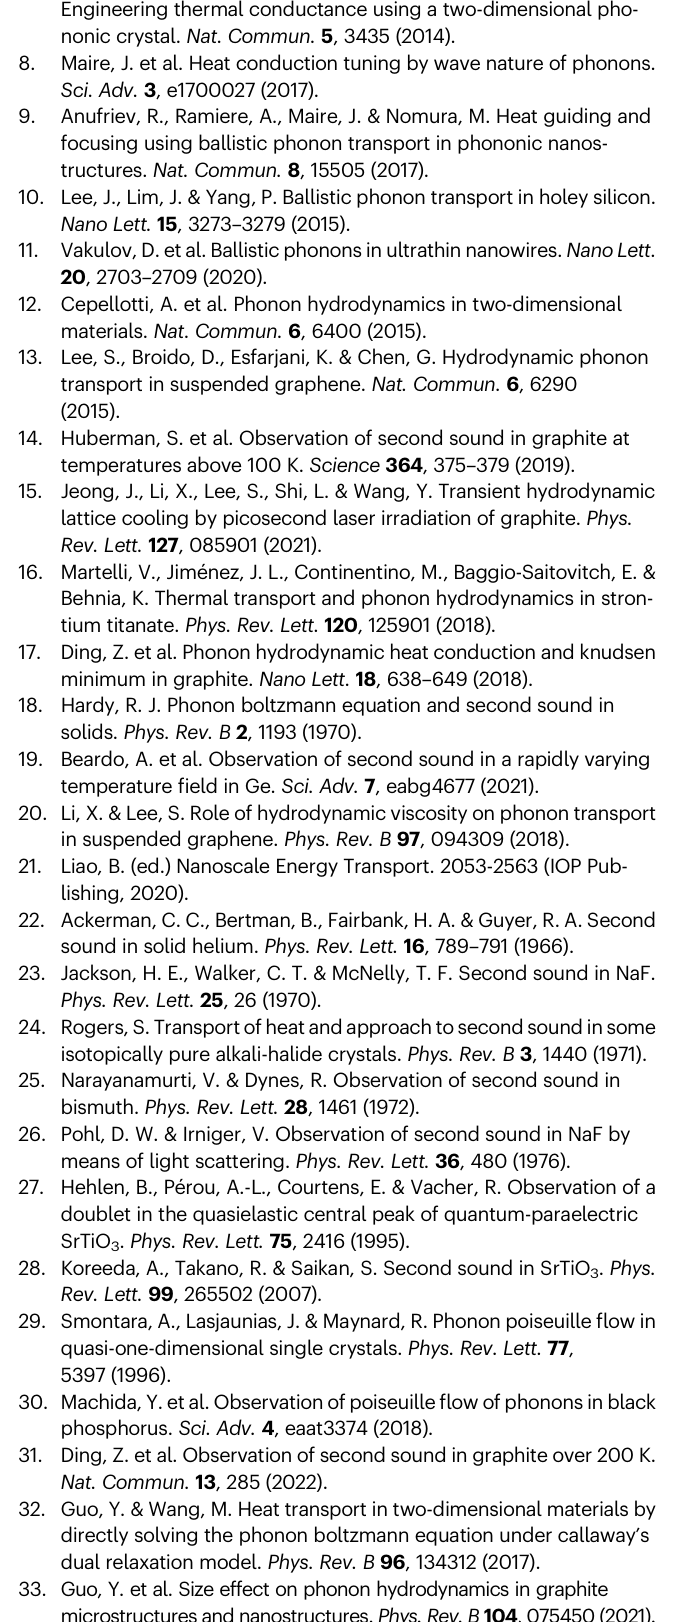
Fig. 9. By injecting a 2 μ s heat fl ux pulse with a Gaussian